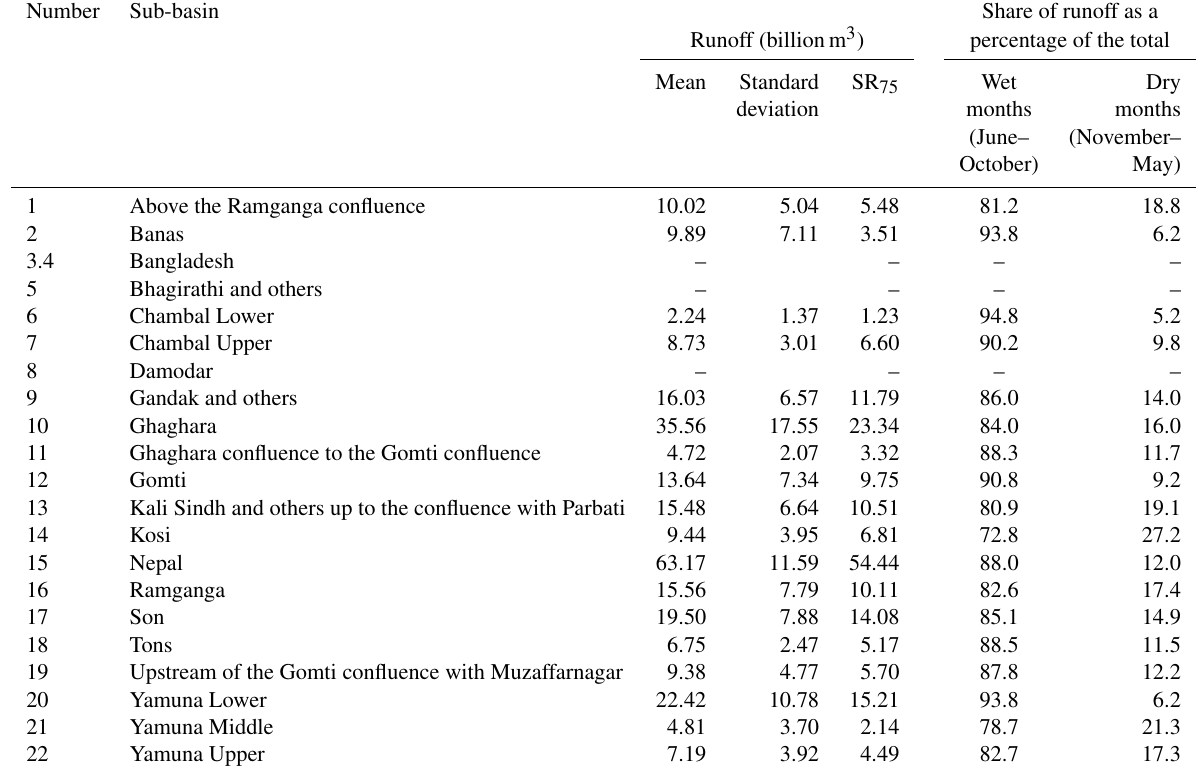
Table 3. Runoff of the